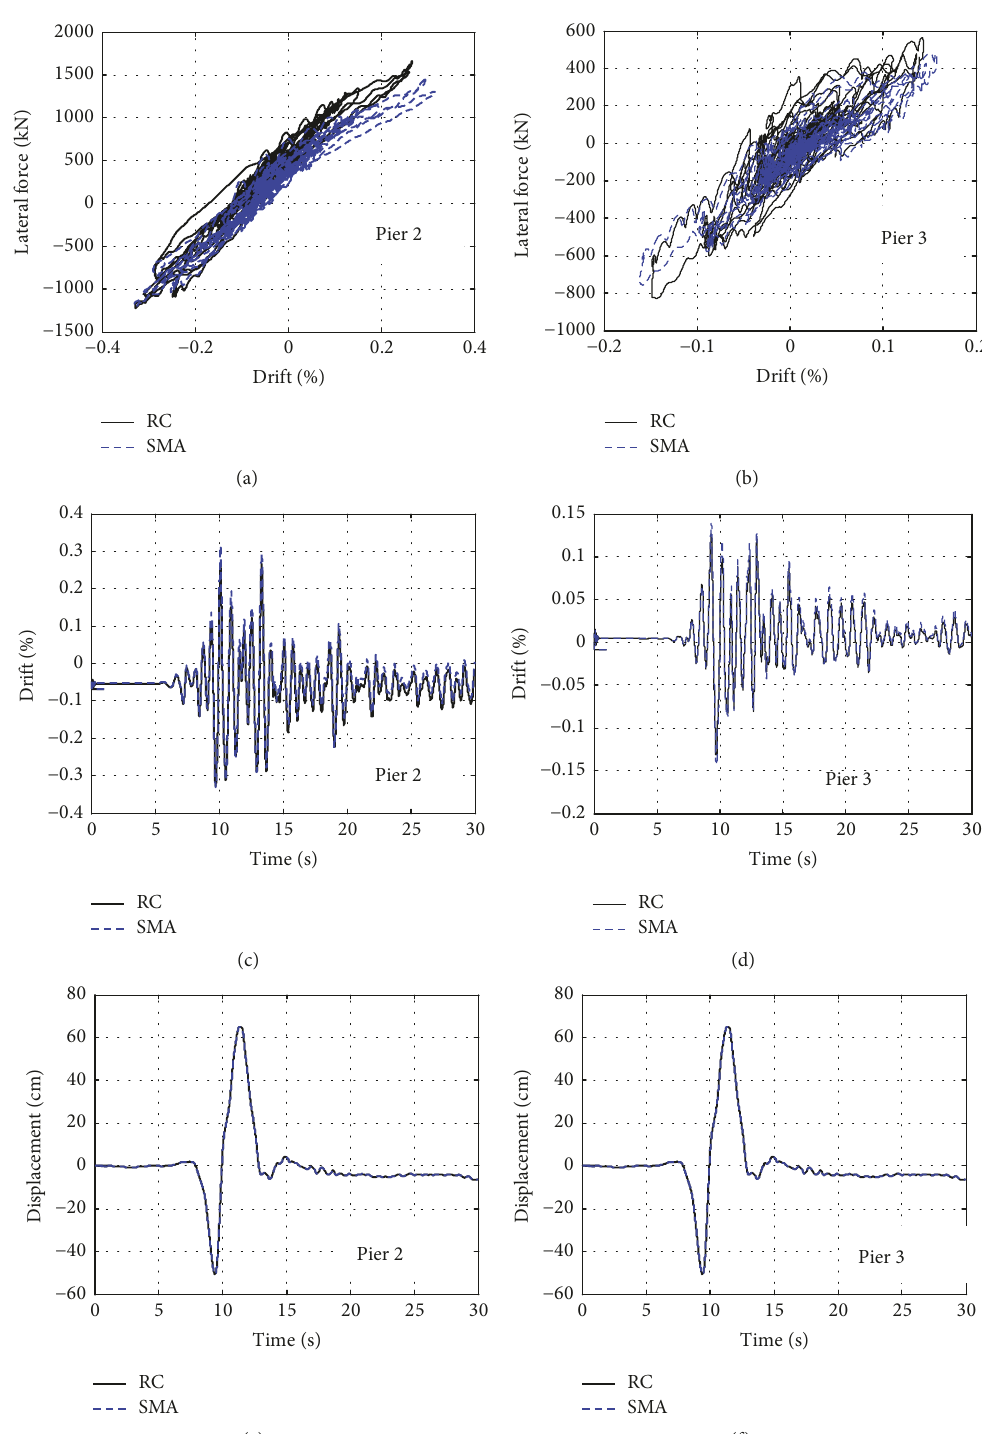
Figure 16: The response of Pier 2 and Pier 3 with full amplified motions: (a) and (b) base shear versus drift hysteresis curves; (c) and (d) relative drift of piers; (e) and (f) top displacement history of